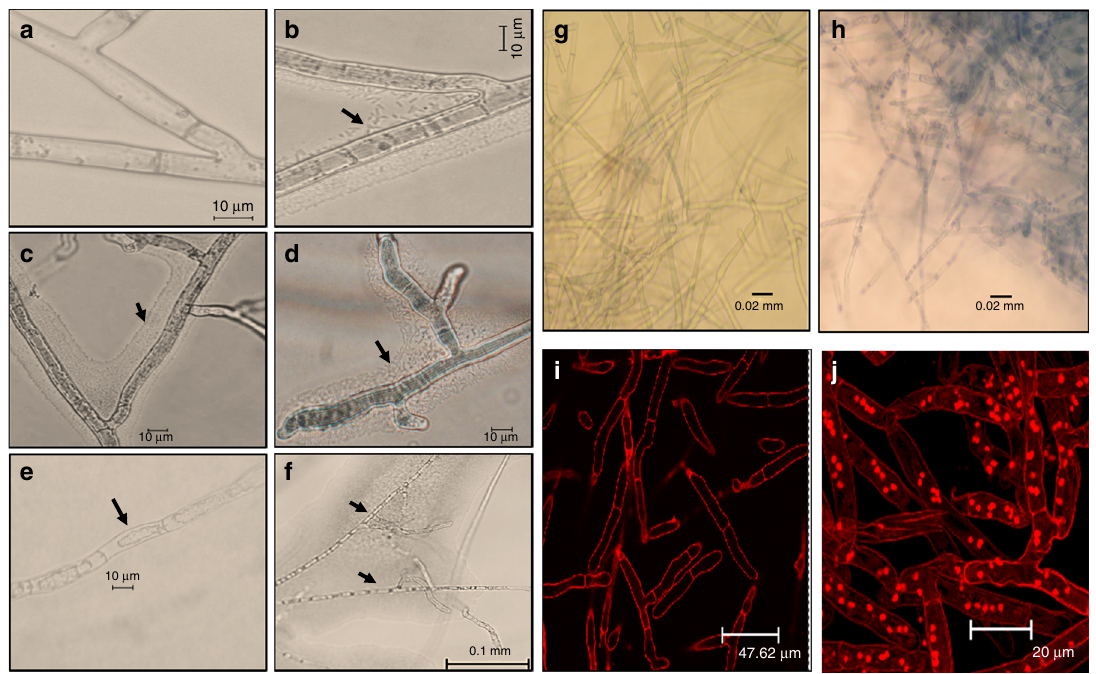
Fig. 2 Treatment with B. gladioli strain NGJ1 induces cell death in R. solani . Microscopic view of a untreated and b – f NGJ1-treated mycelia. Majority of bacteria were found associated with fungal mycelia forming a thin fi lm around the mycelial surface during 24 h of confrontation b , c . Alterations in mycelial integrity such as shrinkage of cytoplasm e and hyphae degeneration etc. were observed during 48 – 72 h of confrontation d , f . The untreated mycelia did not show any such alteration a . Microscopic images of trypan blue and propidium iodide (PI) stained NGJ1 untreated and treated R. solani mycelia. The uptake of trypan blue h and PI j stains in bacteria-treated mycelia suggested cell death while lack of trypan blue g and PI i staining in untreated mycelia indicates that they are alive. Similar results were obtained in at least three independent